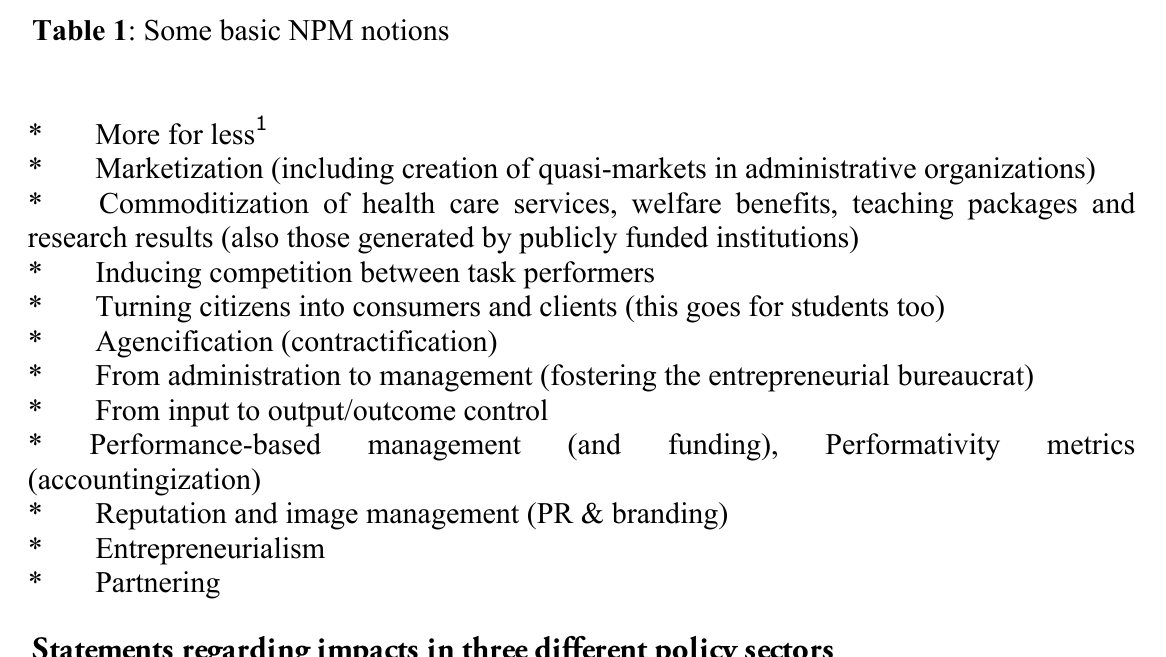
Table 1 : Some basic NPM